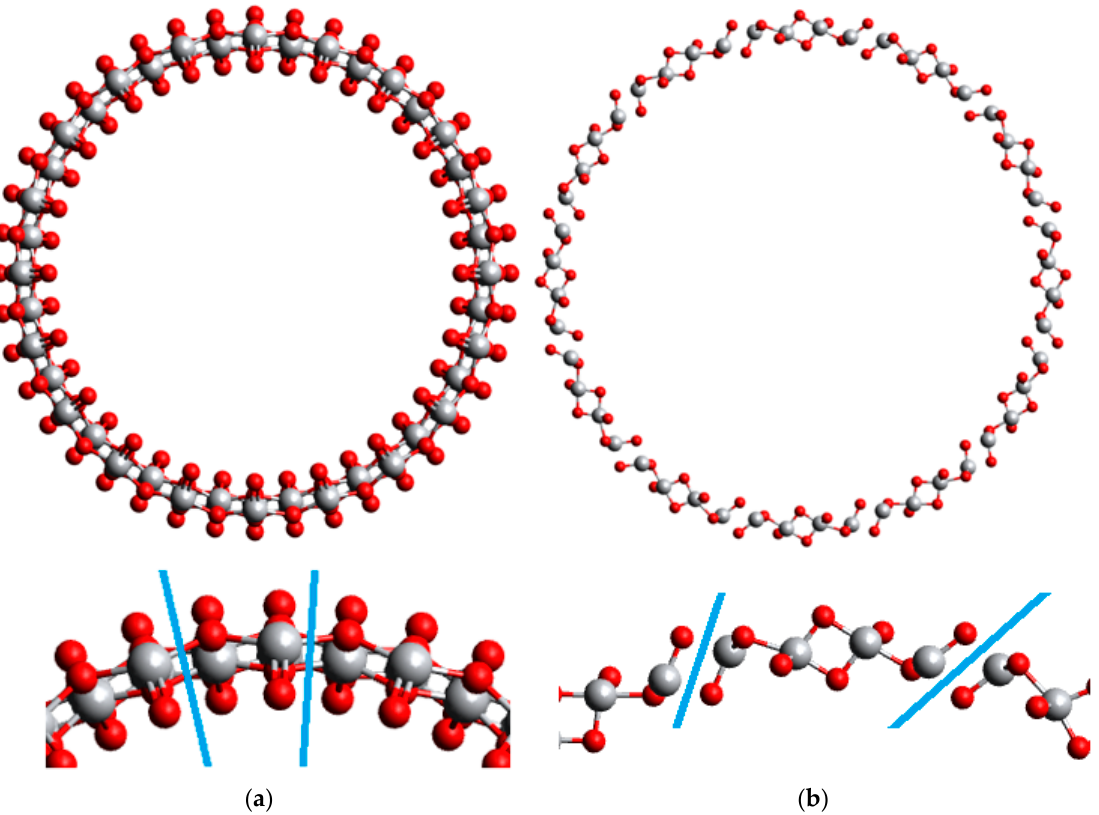
Figure 1. Structures of 6-layered (101) TiO 2 NTs. Unit cells are depicted with blue lines in the magnified segments. ( a ) ( n ,0) configuration; ( b ) (0, n ) configuration.